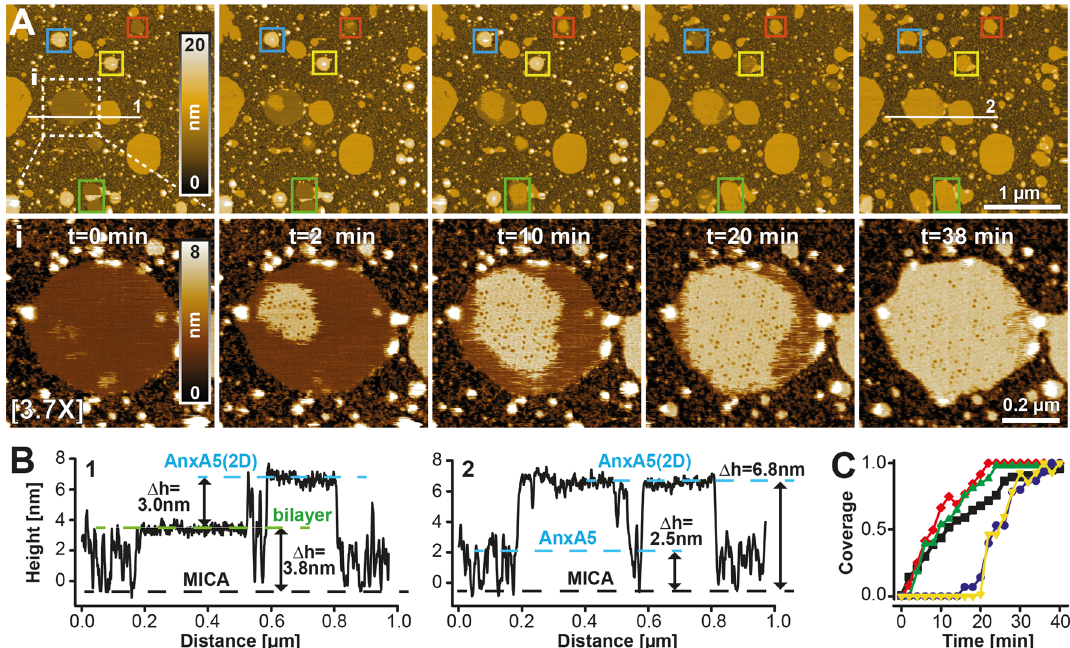
Figure 4. Time-lapse imaging of AnxA5 crystal growth. ( A ) Time-resolved 4 megapixels high resolution topographies of growing AnxA5 p6 crystals imaged over an area of 2.7 × 2.7 µm 2 at 17 Hz line frequency (2 min/ frame). Isolated AnxA5 crystals, membrane patches, as well as intact lipid vesicles are observed. HS-AFM recording captured liposomes adsorbing to and then spreading on the mica surface (blue and yellow boxes). Subsequently, several growing AnxA5 p6 crystals could be observed (blue, white, green, yellow, and red boxes) in a single experiment. Enlargement (3.7×) of the white boxed area at the bottom of each corresponding frame highlights different steps during crystallogenesis. After initial self-assembly into small aggregates (t = 0 min), growth of the 2D-lattice was observed (from t = 2 min) until the membrane was fully covered (t = 38 min). ( B ) Cross-sectional analysis along the white lines shown in ( A ) at t = 0 min (left panel) and t = 38 min (right panel). After AnxA5 lattice has fully covered the membrane patch, its height increases from 3.8 to 6.8 nm, or about 3 nm. ( C ) Time-course of AnxA5 crystal growth for the five membrane patches indicated by the boxed areas in ( A ). Individual panels and plots were generated using ImageJ 1.52e (https:// imagej. nih. gov/ ij/ index. html) and/ or Matlab 2020b (https:// it. mathw orks. com/ produ cts/ matlab. html). Final figure was assembled, edited, and rendered with Adobe Creative Cloud suite (https:// www. adobe. com/ creat ivecl oud. aggregates (Fig. 4A inset, t = 0) and the subsequent large-scale growth of the p6 crystal lattice (Fig. 4A inset, from t = 2 min) over five different membrane domains (highlighted by five colored boxes in Fig. 4A). Cross-section analysis indicates that the membrane patch height increases by about ~ 3 nm (Fig. 4B) upon AnxA5 adsorption and assembly, consistent with the notion of annexin being a peripheral membrane protein and in agreement with previous AFM studies 24–26 . Under these experimental conditions, full membrane coverage is attained in about 20 min, as shown by the time-course of the surface coverage for the five highlighted membrane domains (Fig. 4C). While Supplemental Movie 4 was acquired at 2 frames per min, a low rate compared to conventional HS-AFM, it was still recorded at remarkably high tip surface speed v s ( v s = 2 L x ( N x / T ) where “ 2 ” arises from the trace/retrace scanning in the x -direction, L x is the length in micrometres of each x -scan line, N x designs the number of x -scan lines composing the frame and T is the image acquisition time in seconds) and large pixel bandwidth f p (for an N × N pixel image f p = 2 N 2 / T ). Scan speed and pixel bandwidth correspond to v s = 90 µm/s and f p = 67 kHz ( v s = 2*2.7*(2000/120) = 90 µm/s; f p = 2*2000 2 /120 = 67 kHz), respectively, and are comparable to typical values of v s = 100 µm/s and f p = 100 kHz attained by imaging a 100 nm 2 area at 5 frames per s with standard HS-AFM scanners ( v low noise is also possible: a silicon grating was imaged at 2 s/frame (100 Hz line rate) over a 36 × 36 µm 2 area, corresponding to a high scan speed of 7.2 mm/s (Suppl. Movie 1). Large frame, live‑cell HS‑AFM imaging. Adherent mammalian cells often span over several tens of micrometer, and standard HS-AFM system can therefore only image small subsets of the full cellular surface. In contrast, commercial Bio-AFM scanners offer maximal scan sizes covering entire cells (100 × 100 µm 2 ), but their comparatively low scan speeds and in some cases limited pixel bandwidths prevents the acquisition of topog- raphies at frame rates needed to temporally resolve dynamics membrane associated cellular processes, such as endo- or exocytotic events, or cortical cytoskeletal re-arrangement. Using our wide-range scanner, we were able to image 27 × 16 µm 2 frames covering an area of dynamic membrane remodelling at the periphery of a living fibroblast at 20 s/frame (Fig. 5 and Suppl. Movie 5). In addition to continuous submembranous cytoskeleton